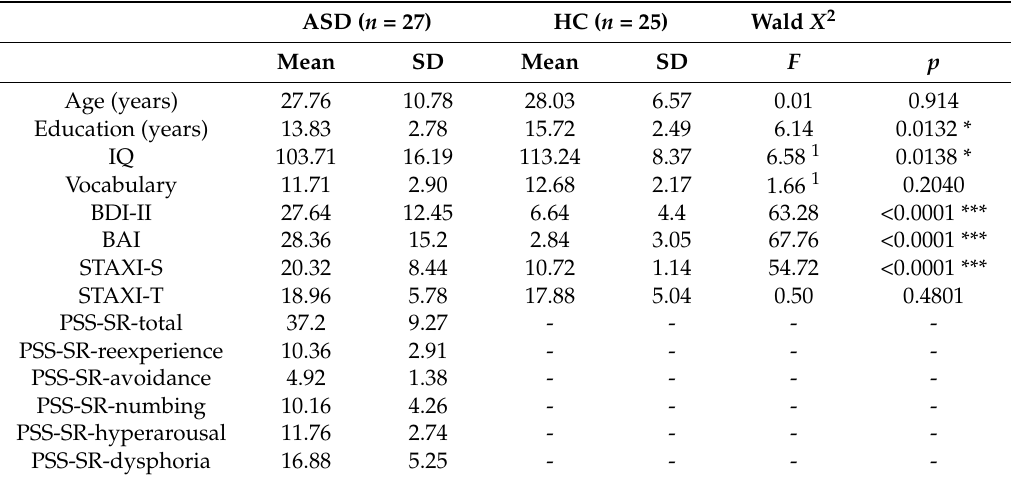
Table 1. Descriptive statistics for demographic and clinical variables.